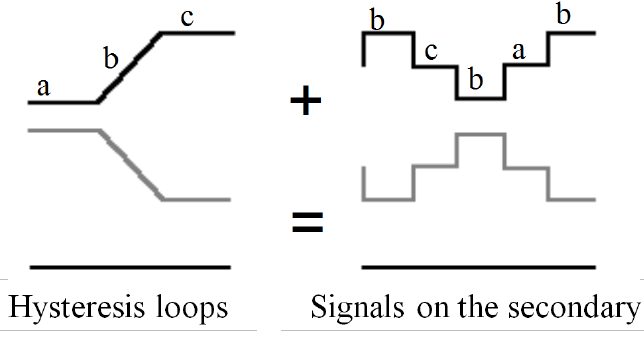
Figure 8. Signal of each core without external field